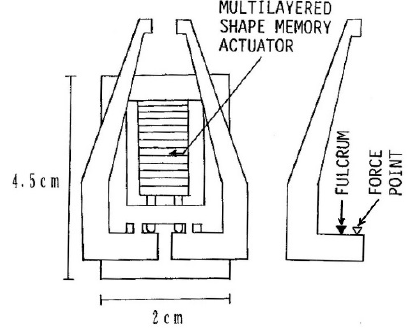
Figure 24. Construction of the mechanical damper using a shape memory multilayer device.